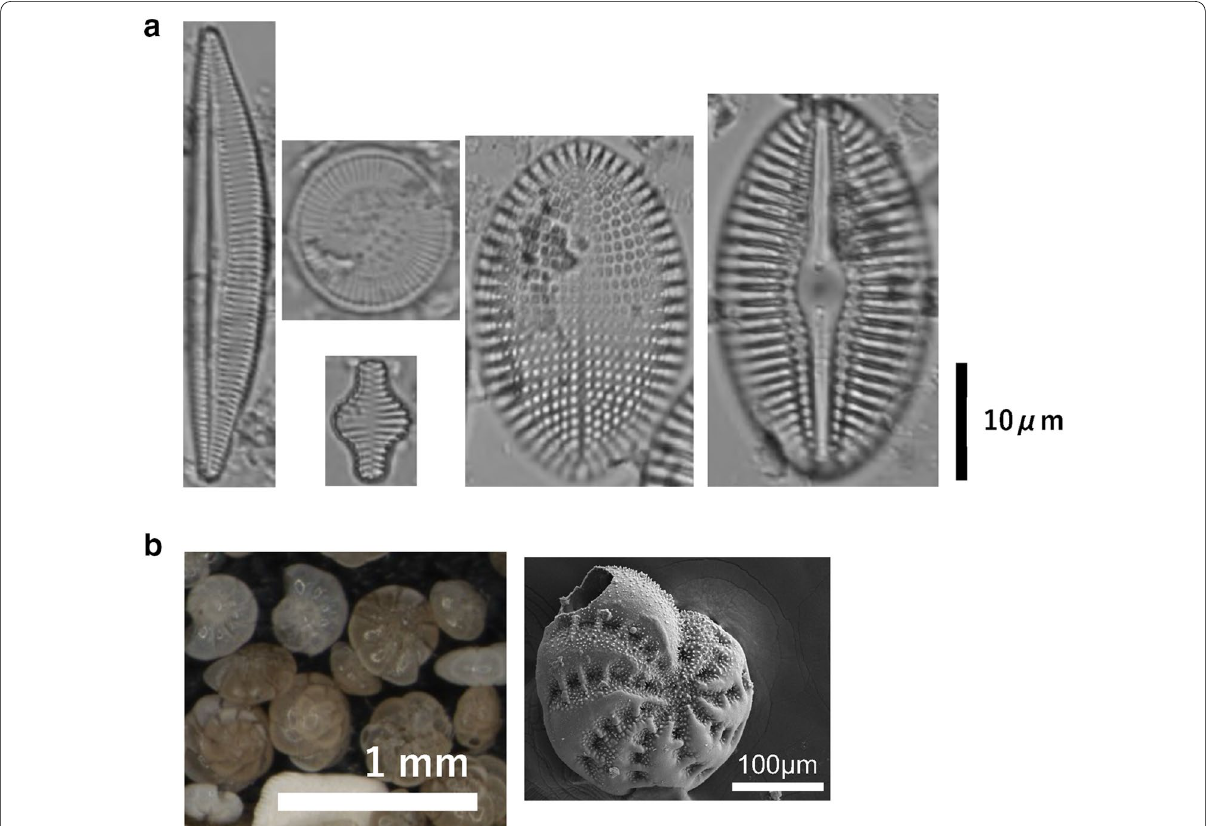
Fig. 4 Photos showing microfossils used for sea-level reconstructions. a Diatom from coastal sediments in Shimokita plane, Japan (Yokoyama et al. 2012) and b benthic foraminifers in sediment cores obtained from Bonaparte Gulf, Australia (Ishiwa et al. 2016)